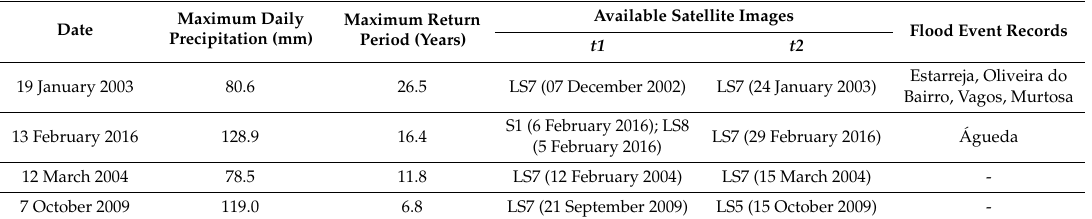
Table 5. Selected precipitation events, available satellite images (LS—Landsat; S—Sentinel) and flood event records. For a complete list, consult Table A1.